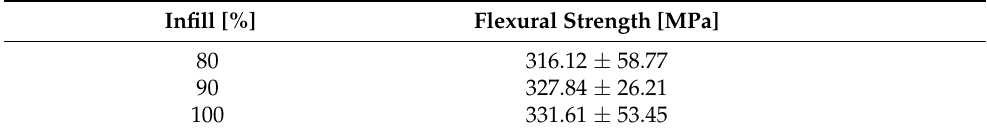
Table 4. Flexural strength depending on the internal